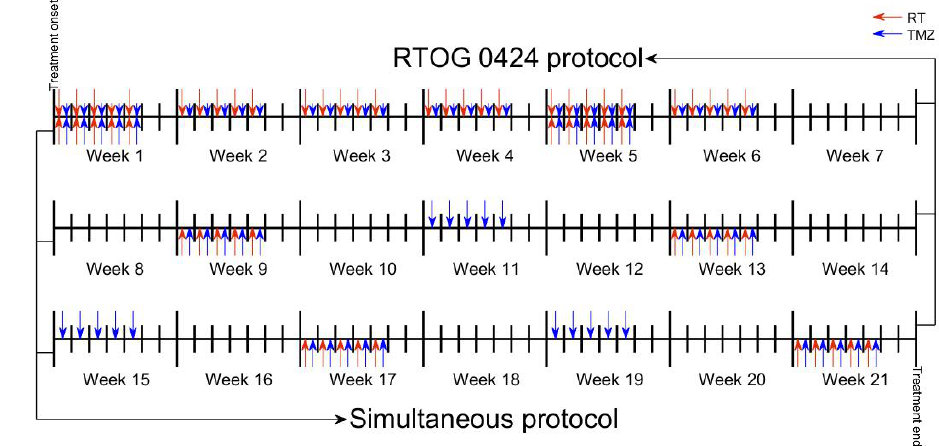
Figure 7. Schematic representation of the combined treatment protocols. In the RTOG 0424 protocol, RT was given concurrently with TMZ (75 mg/m 2 /day) in weeks 1–6 (top of treatment timeline) while in the simultaneous scheme, RT was only administered together with TMZ (150 mg/m 2 /day) (bottom of treatment